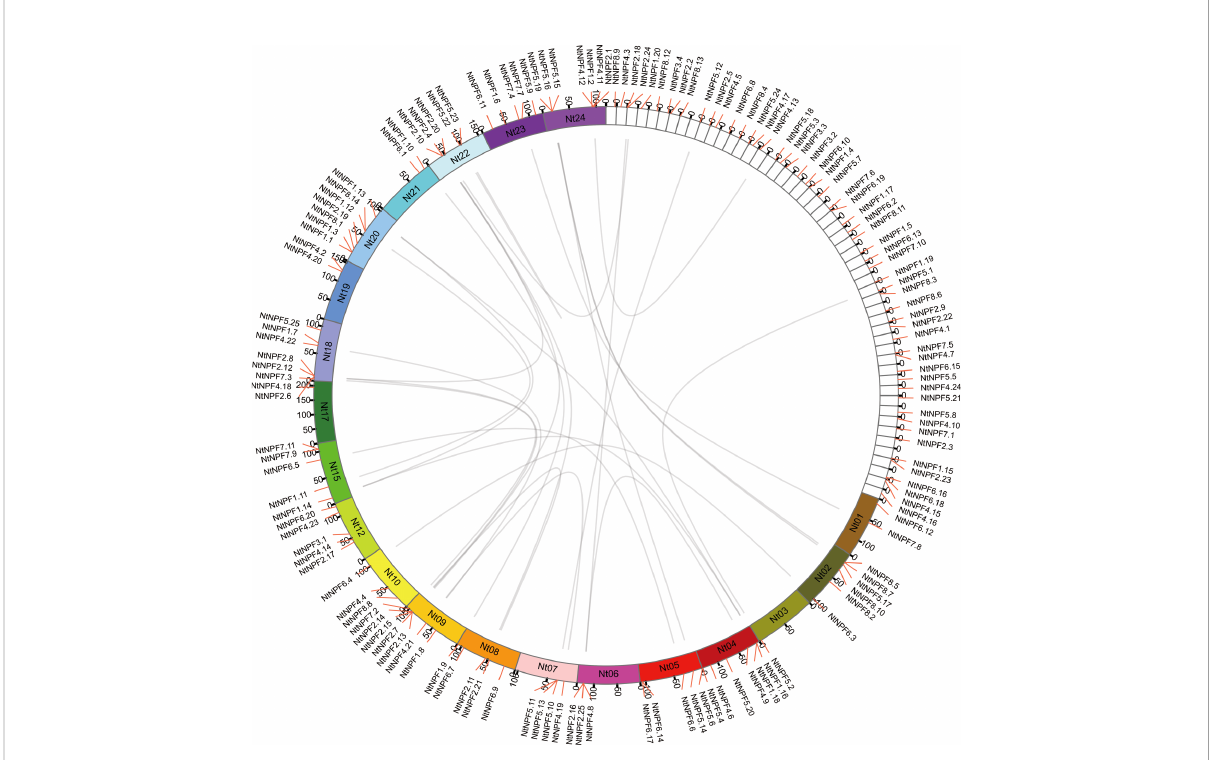
FIGURE 2 Chromosomal distribution and segmental duplication of NtNPF genes in tobacco. The panel shows the 20 chromosomes and unassigned scaffolds using a circle; gray lines connect homologous